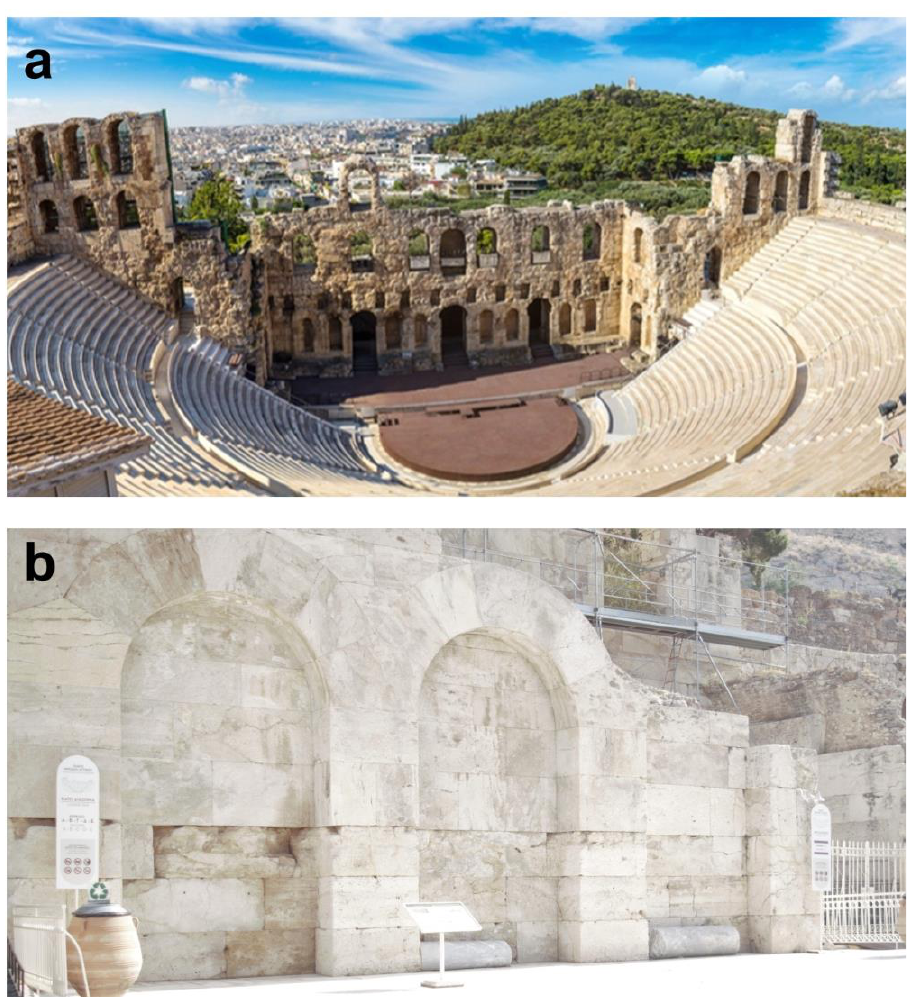
Figure 9. ( a ) Panoramic view of GS5: Odeon of Herodes Atticus – Herodeion ( b ) Details of the building stones in GS5: Odeon of Herodes Atticus – Herodeion (Photo by Fani Tripolitsiotou). stones in GS5: Odeon of Herodes Atticus–Herodeion (Photo by Fani